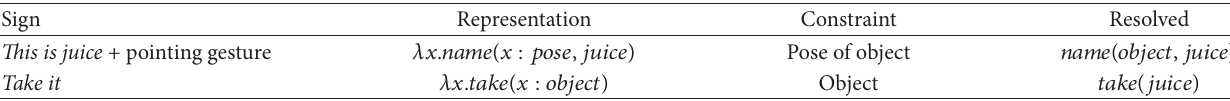
Table 1: Examples of indexical expressions and their